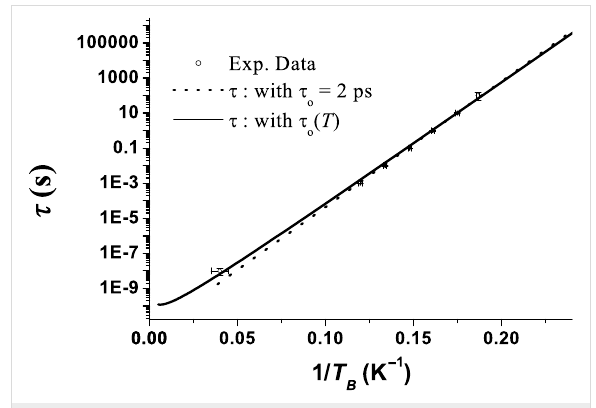
Figure 10: Relaxation time versus the inverse of